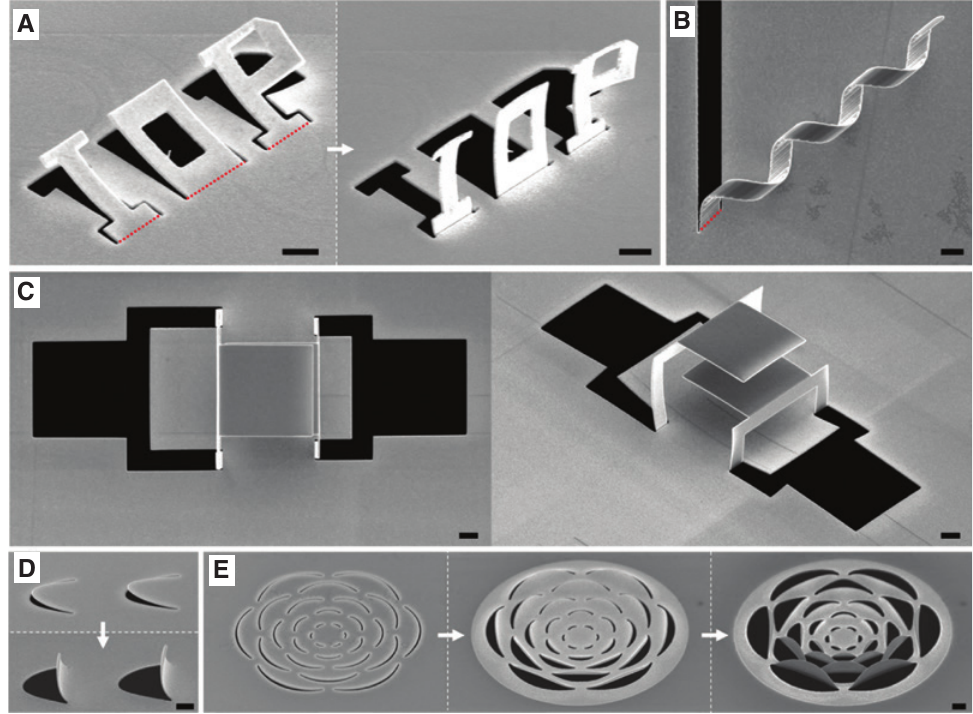
Figure 3: FIB-based tree-type folding/bending. (A–C) Local FIB-irradiation-induced folding of (A) “IOP” letters, (B) a horizontal spiral, and (C) a triple-layer structure. (D, E) Global FIB- irradiation-induced bending of (D) tongue-like and (E) flower-like structures [39]. Scale bars: 1 μ